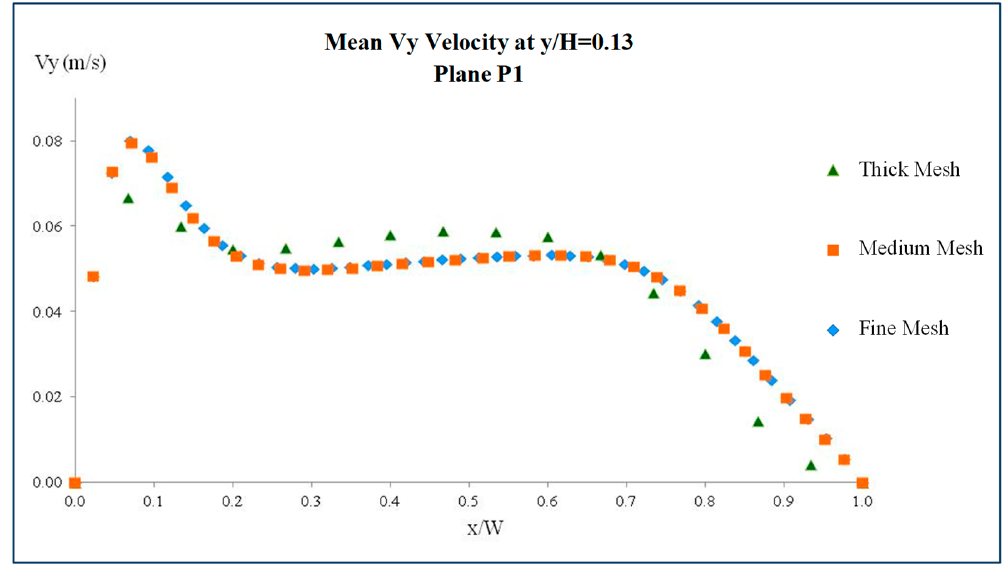
Figure 7. Comparison of vertical velocity profiles for Ra = 1.0 × 10 9 conditions in the P1 plane at y / H = 0.13 in the cavity.